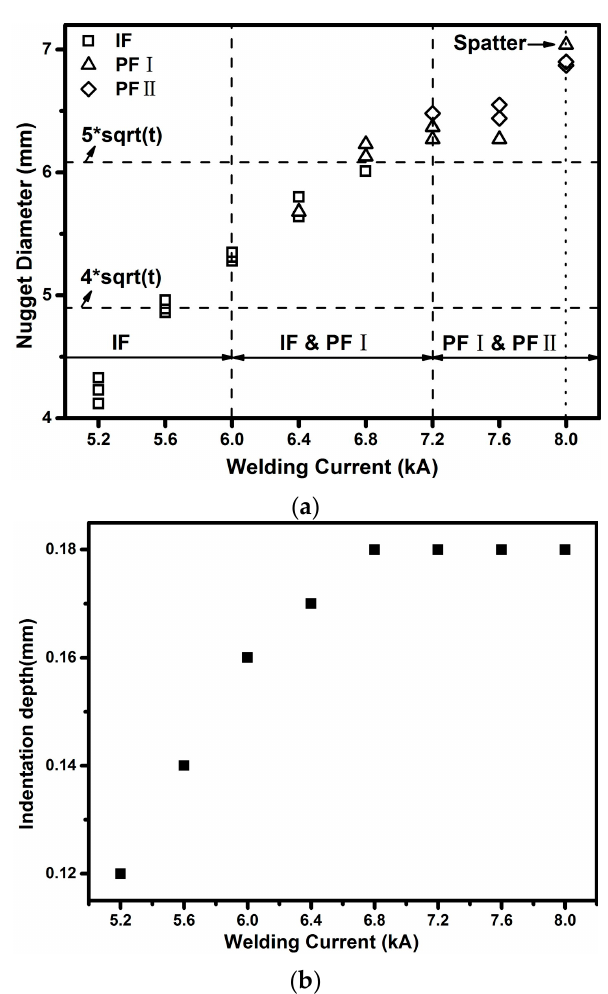
Figure 5. Effect of welding current on the: ( a ) nugget diameter; ( b ) indentation depth.